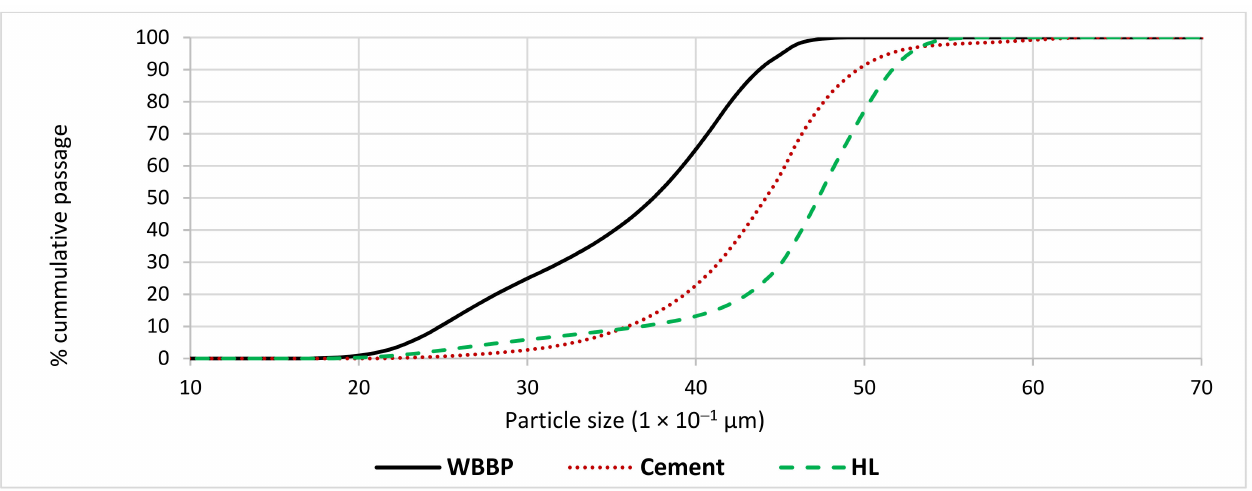
Figure 2. The particle size distribution of cement, waste burnt brick powder (WBBP), and hydrated lime